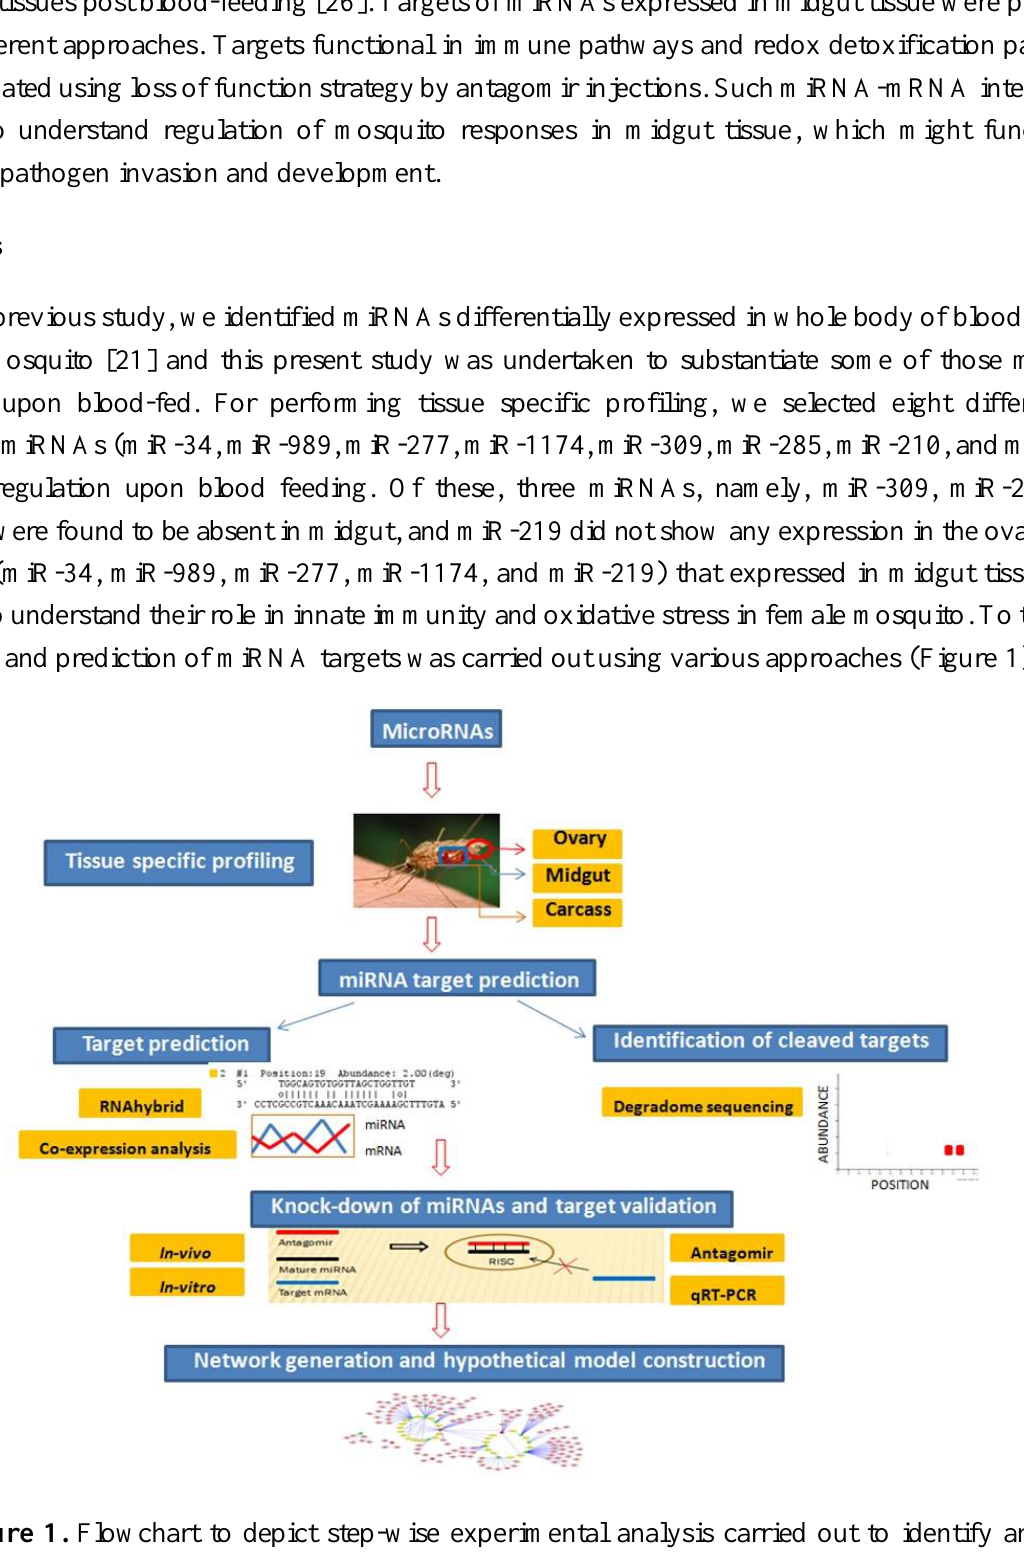
Figure 1. Flowchart to depict step-wise experimental analysis carried out to identify and validate miRNA targets functional in oxidative stress and innate immunity pathways in midgut tissue of female